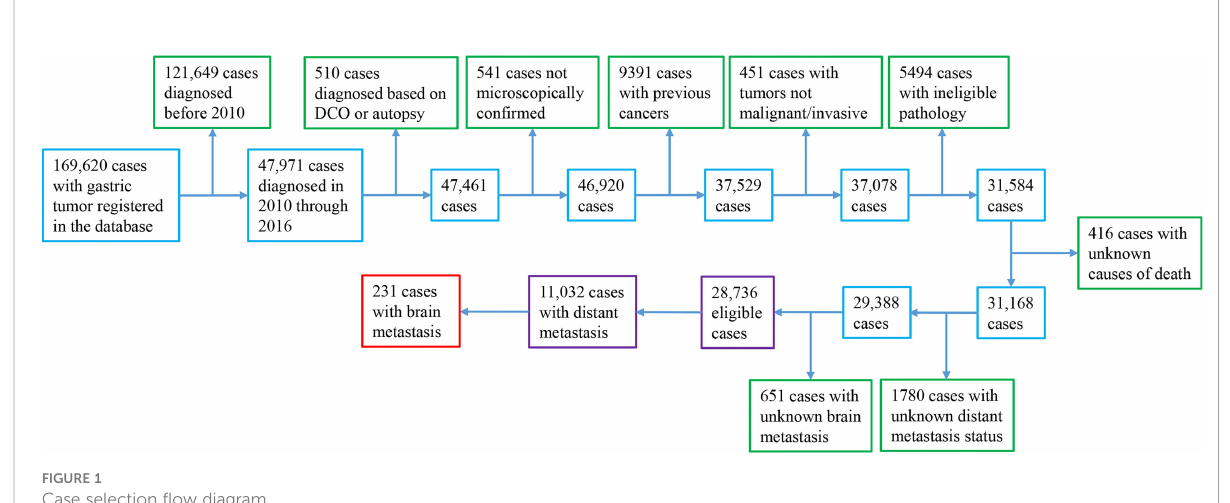
FIGURE 1 Case selection fl ow